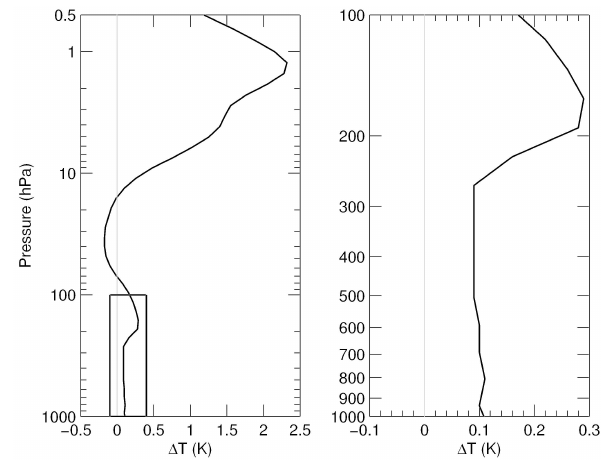
Fig. 12. Temperature changes between 2001 and 2050, calculated from a radiative-convective model. Panel (b) is zoomed on the box in panel (a)